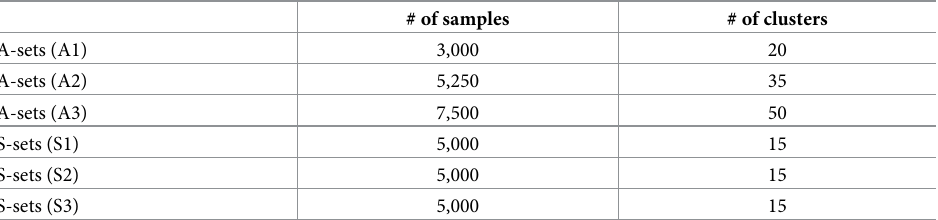
Table 1. Statistics of the A-sets and the S-sets.